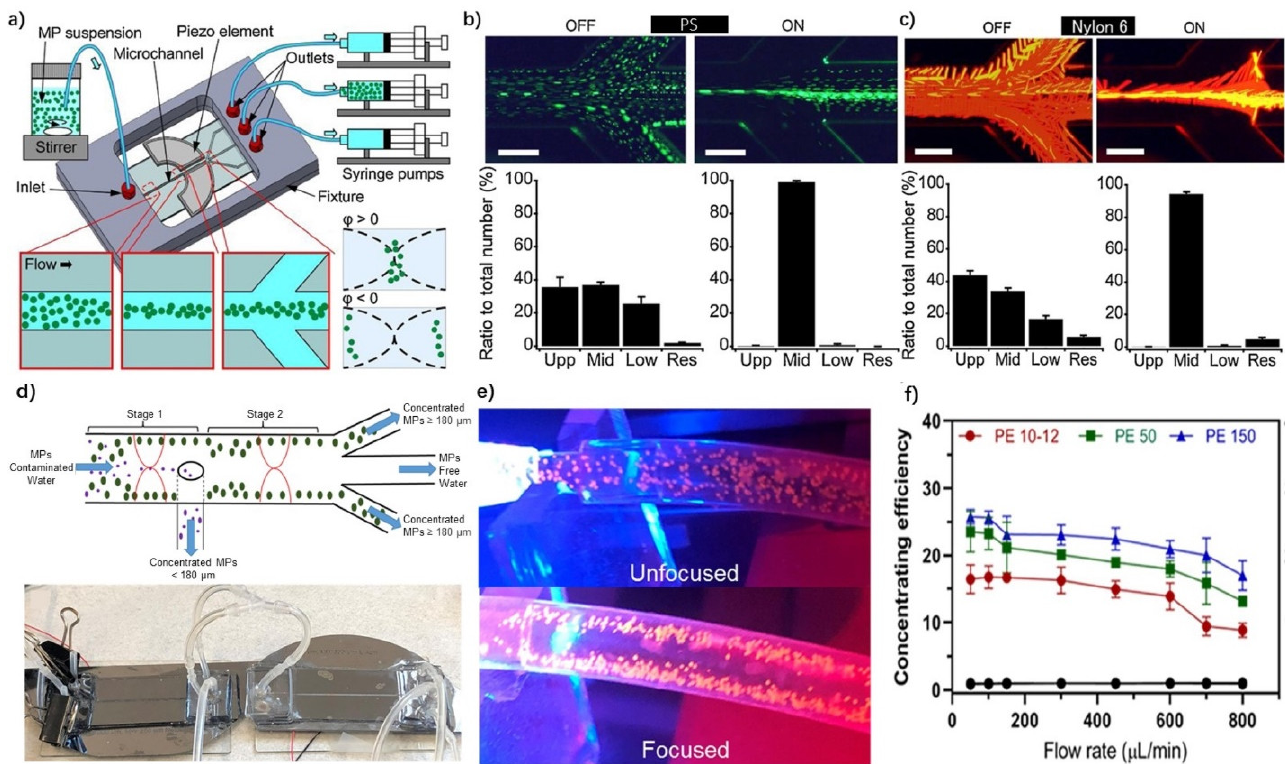
Figure 3. Physical separation methods utilized for the separation and collection of MPs. ( a ) Illustra- tion of the acoustic focusing integrated microfluidic platform, demonstrating the mobility of MPs with the application of the focusing. ( b , c ) The collection yield of PS and Nylon 6 MP was higher when applying acoustic focusing. Reprinted with permission from [65]. Copyright 2020, Elsevier. ( d ) Removal capacity for MPs larger than 180 µ m, as well as an image of the microfluidic system. ( e ) Direction of MPs using acoustic focusing. ( f ) Analysis of the relation between the concentration efficiency of PE and the flow rate. Reprinted with permission [66]. Copyright 2022,